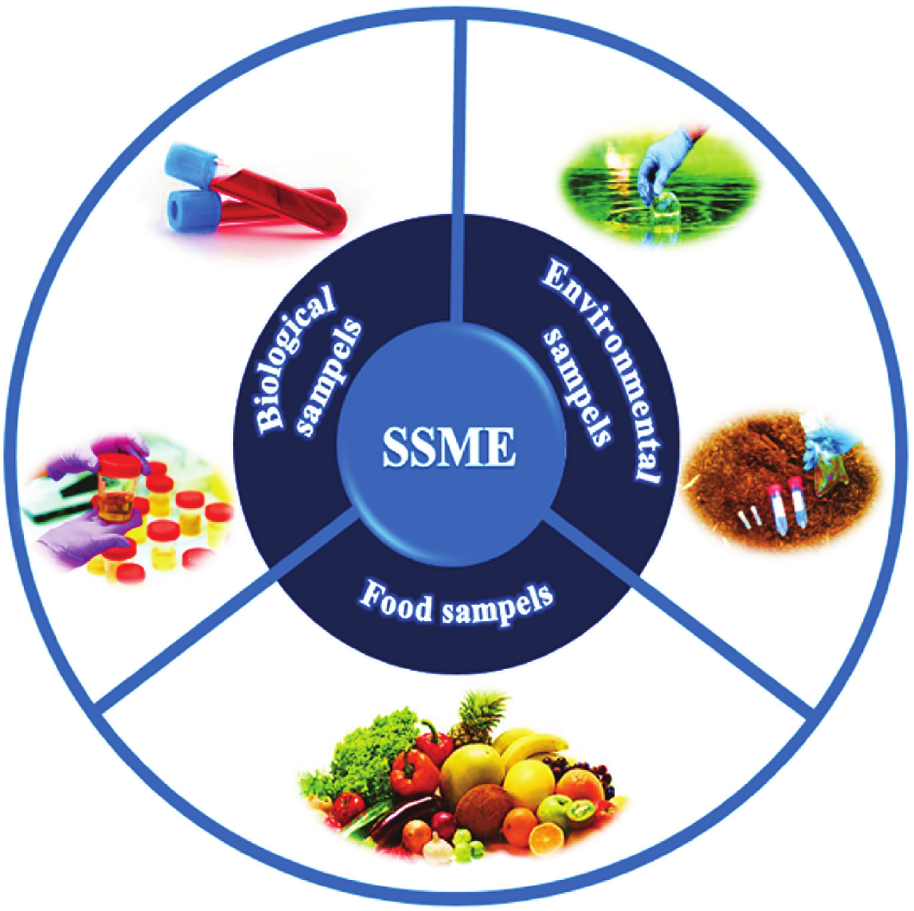
Figure 2: Schematic representation of the applications of SSME for sampling and analysis of heavy metals from different